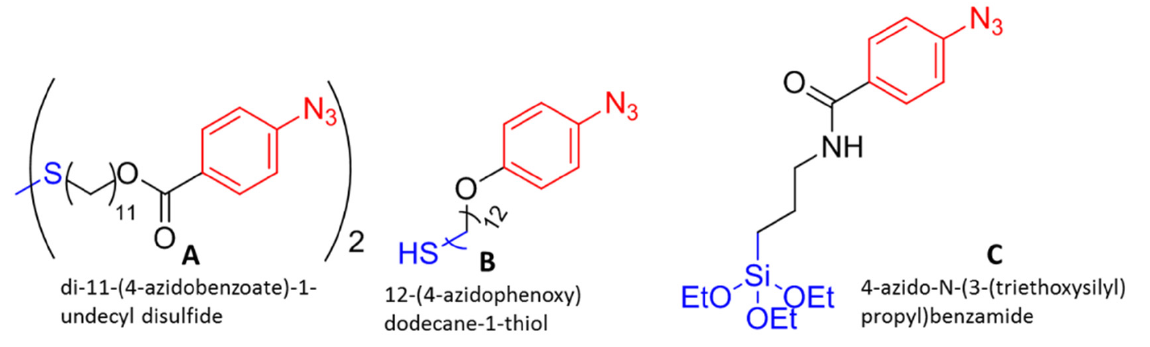
Figure 15. Phenyl azides (red) with anchor moieties (blue).